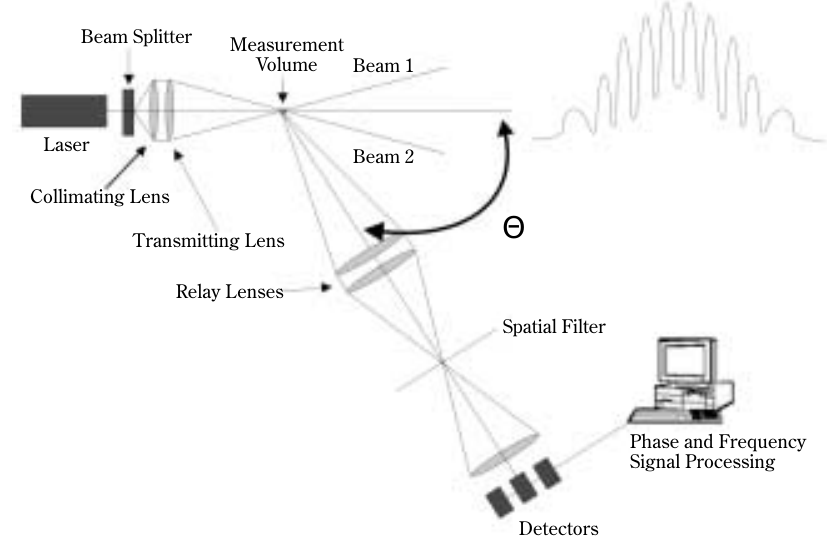
Fig. 15 Schematic of a phase Doppler particle size analysis